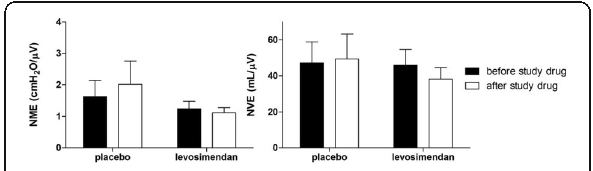
Fig. 1 (abstract 000214). See text for